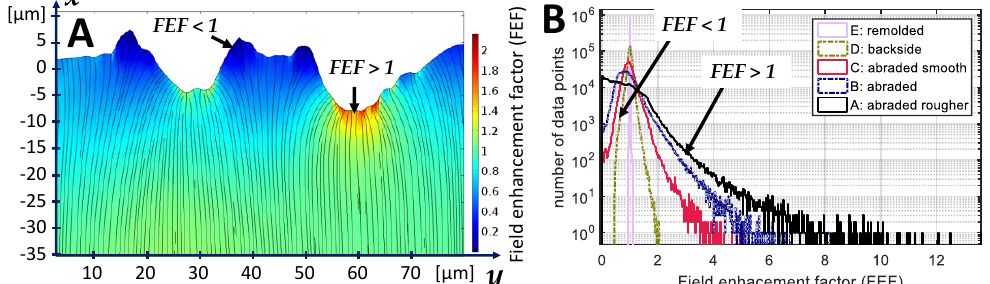
Figure 3. Local field enhancement in the interfacial region of an abraded surface (colormap shows FEF and streamlines show field orientation) ( A , left). Corresponding Field enhancement factor ( FEF ) histograms for the points positioned at the surface ( B , right). Different surface types with different degrees of surface roughness are shown, and the results are obtained from Laplacian field calculation. Surface fractions containing reduced field ( FEF < 1) and increased field ( FEF > 1) are indicated.